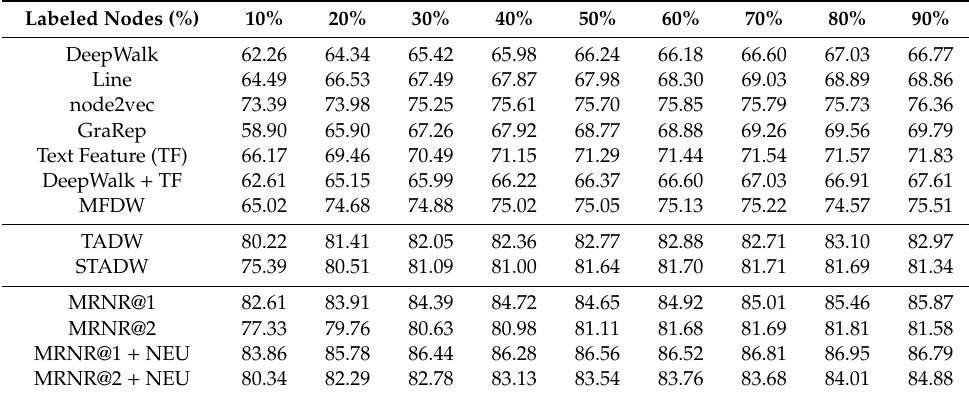
Table 5. Accuracy (%) of vertex classification on the DBLP